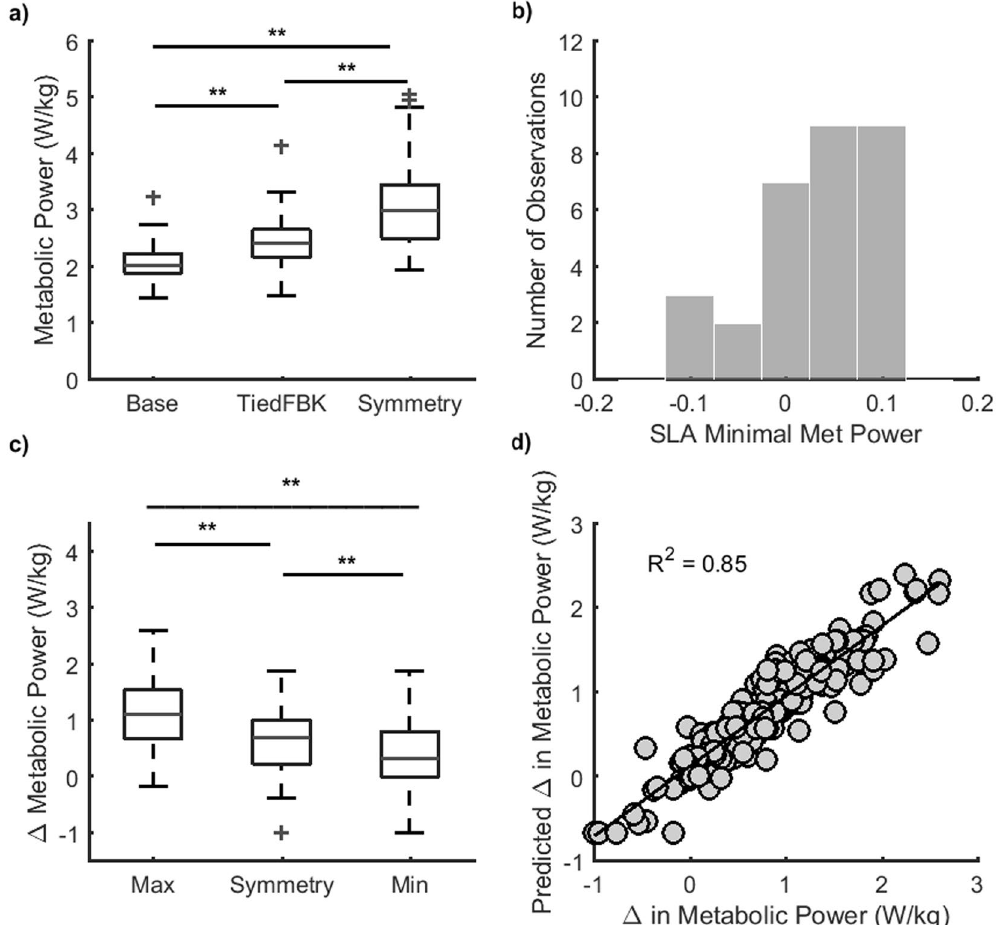
at 0% asymmetry). Significant increases in metabolic cost from BASELINE were measured for all conditions (p < 0.001). ( b ) Histogram of step length asymmetries (SLA) associated with the minimum metabolic cost for all participants. For the distribution of step length asymmetries that produced the minimum cost, values were biased towards asymmetries greater than zero (longer steps on the fast belt). ( c ) Maximum and minimum metabolic cost and metabolic cost during symmetry in the SplitFBK conditions. Here, metabolic cost is expressed as an increase from the TiedFBK conditions to account for the cost of precise foot placement using visual feedback. Significant differences between the maximal, minimal and symmetric metabolic costs were measured at the p < 0.001 level. ( d ) Predicted metabolic cost derived from the linear mixed effects model that tested for associations between asymmetry, direction of asymmetry and metabolic cost (Equation 3 in